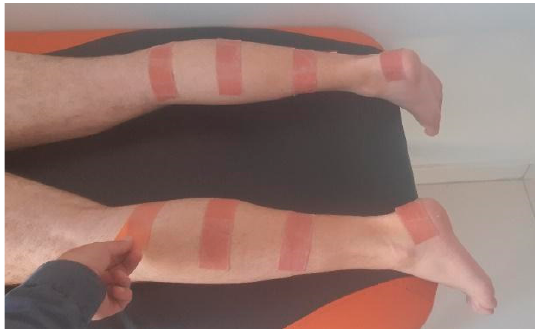
Figure 2. Placebo tape application.